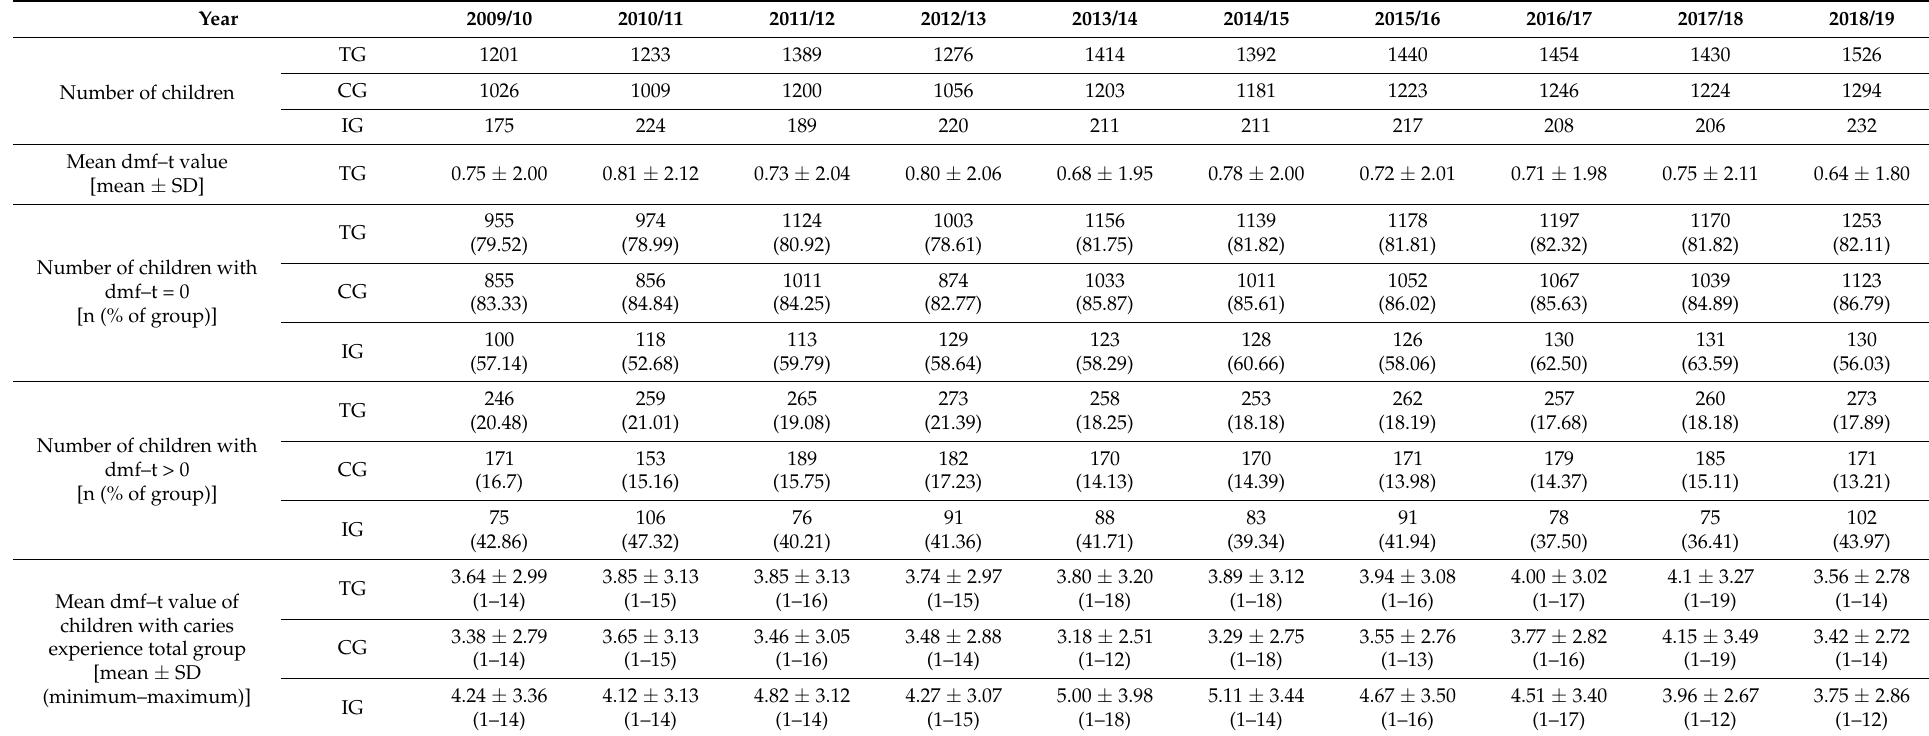
Table 1. Long-term data on caries experience of 3–5-year-old kindergarten children (total group TG, control group with ECC basic prevention CG, intervention group with ECC intensive prevention